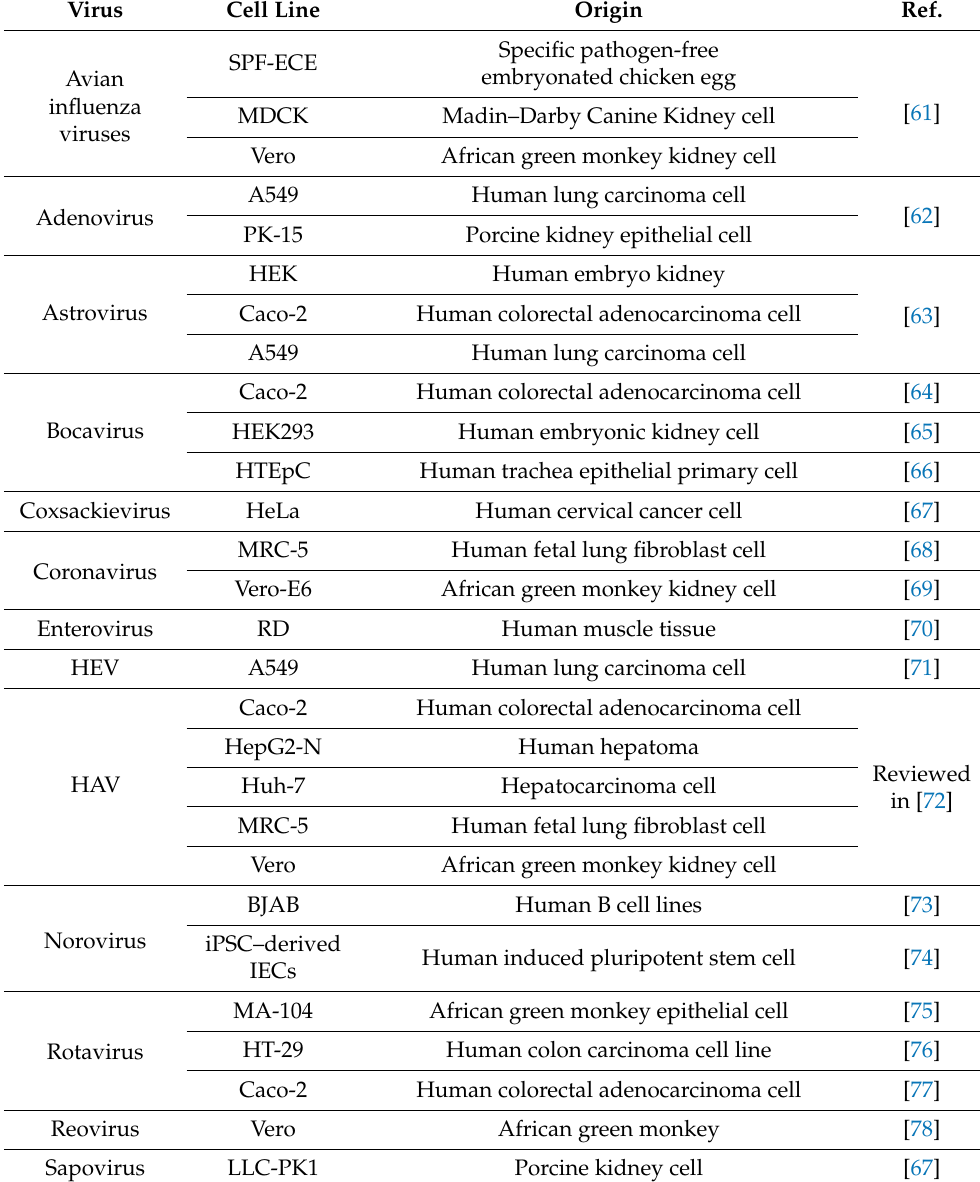
Table 2. Enteric viruses (EVs) and recommended cell culture systems for